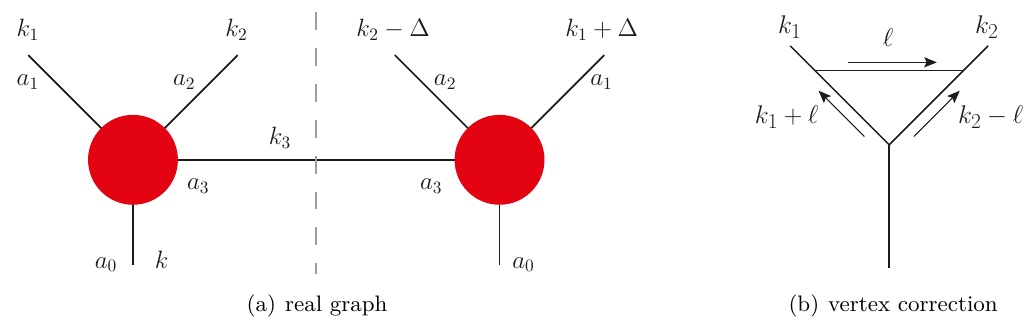
Figure 7 . Left: assignment of momenta in real emission graphs. Plus momenta are fixed to = z = z + , k + + , and ∆ + = 0 . Compared with the symmetric assignment in [19] we have k + 1 k 2 k 1 2 shifted k and k such that ∆ appears only on the r.h.s. of the cut. Right: assignment of momenta 1 2 in vertex correction graphs to the left of the cut. An analogous assignment holds for loops to the right of the cut, with k and k shifted by +∆ and − ∆ , 1 2